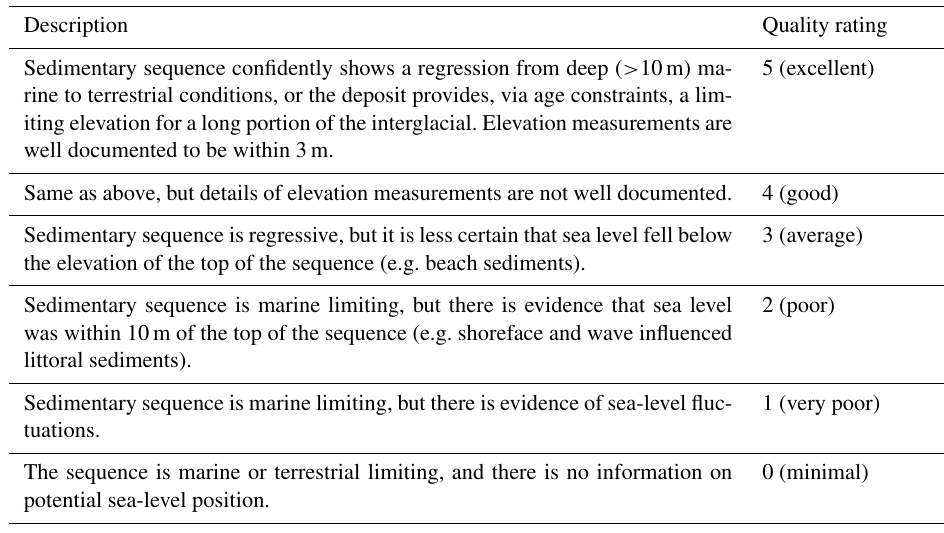
Table 4. Quality scores for age, from the WALIS documentation (Rovere et al., 2020). Description Quality